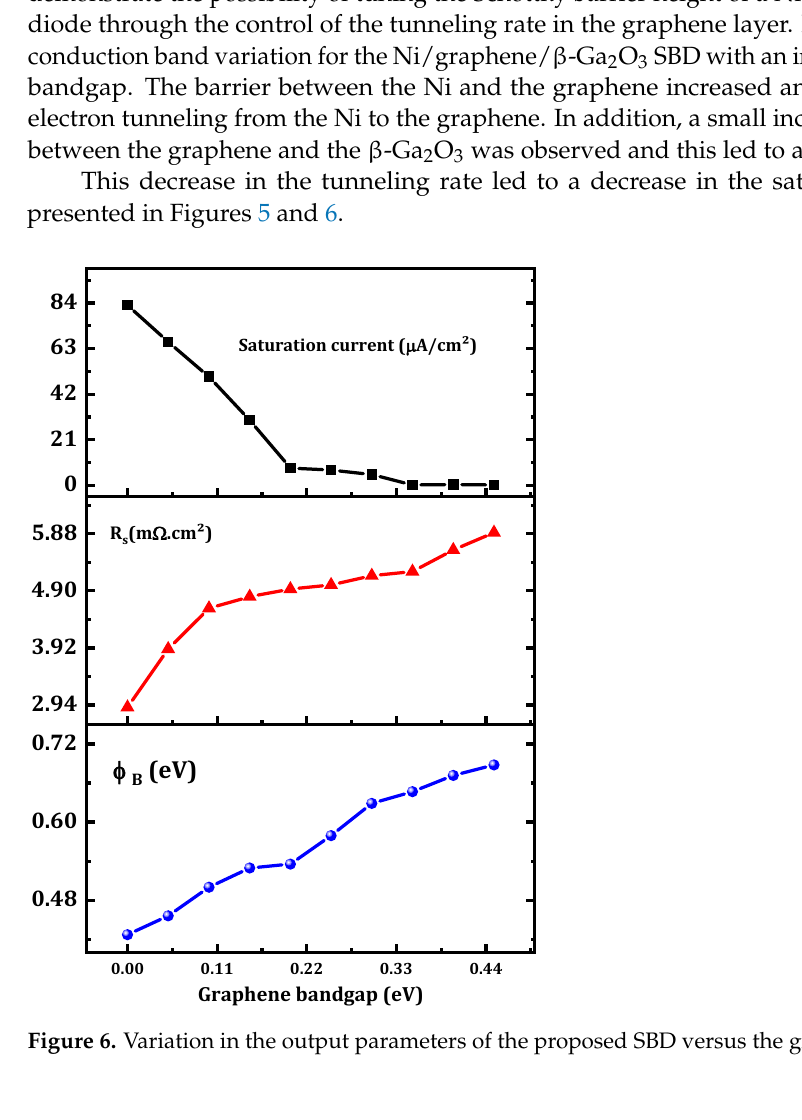
Figure 6. Variation in the output parameters of the proposed SBD versus the graphene bandgap. This decrease in the tunneling rate led to a decrease in the saturation current as pre- sented in Figures 5 and 6.